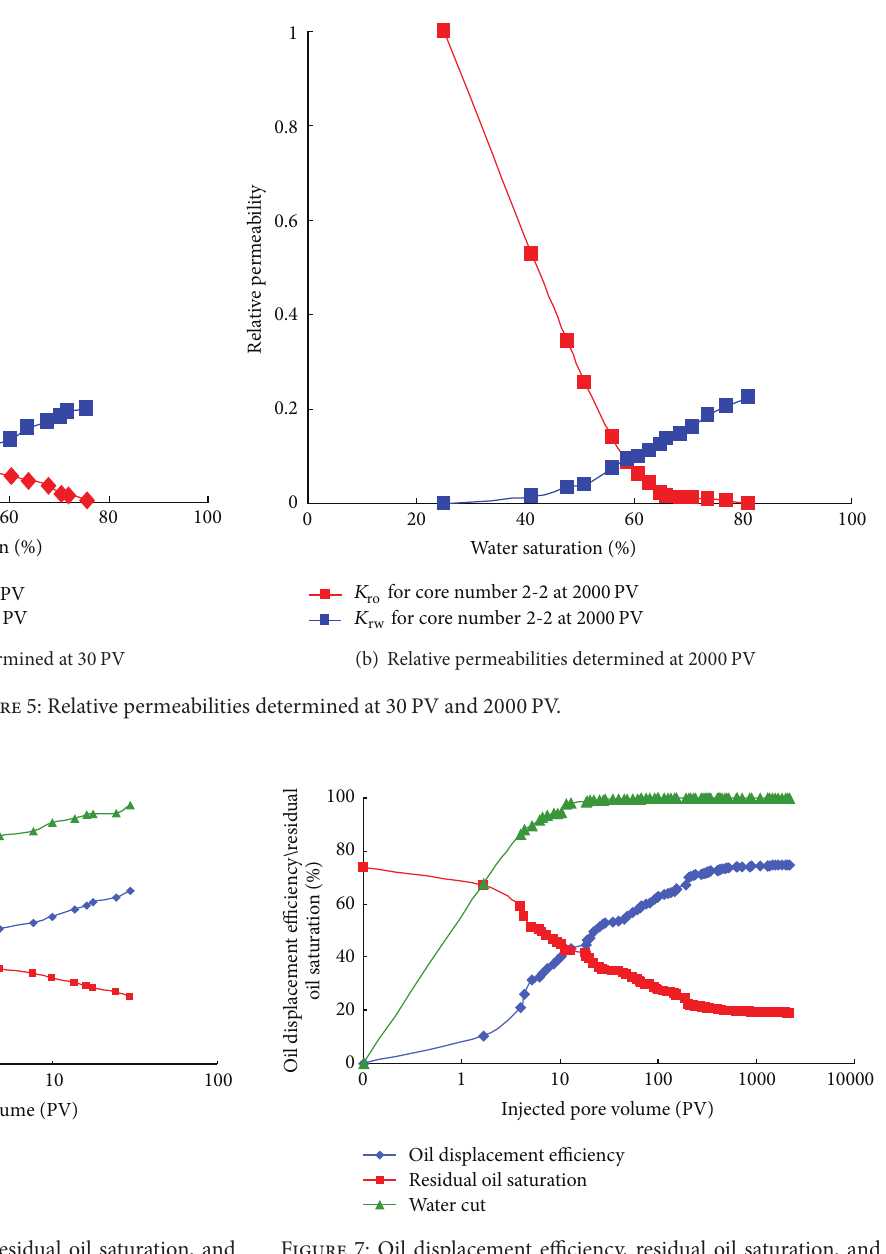
Figure 6: Oil displacement efficiency, residual oil saturation, and water cut with semilogarithmic injected pore volume for 30 PV.